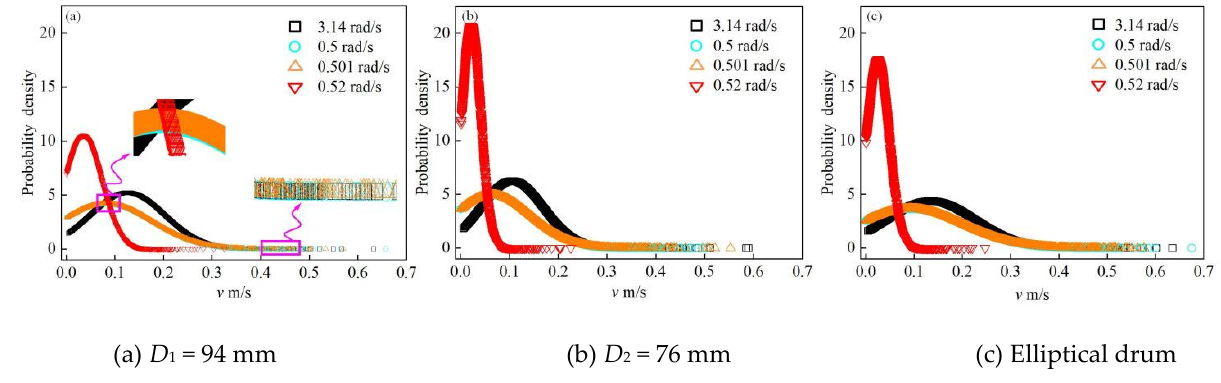
Figure 8. Probability density of particles velocities.